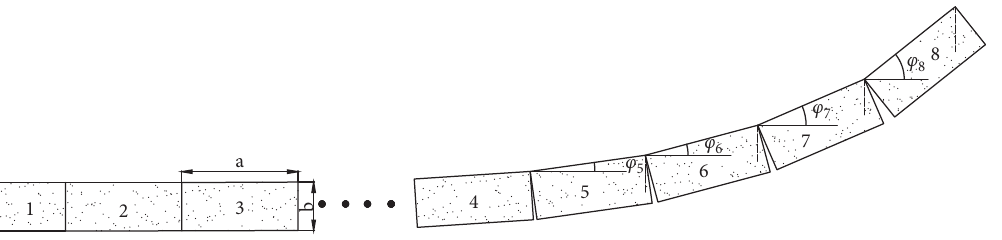
Figure 8: Distribution of rock blocks in the first layer on the side of the head of the working